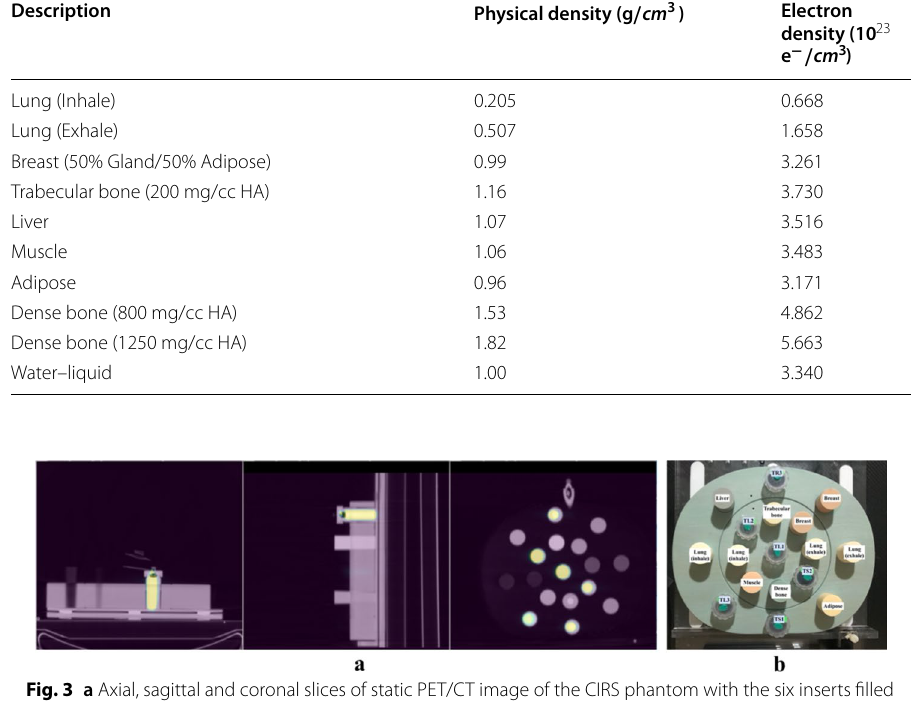
Table 1 Densities for the inserts of the CIRS phantom